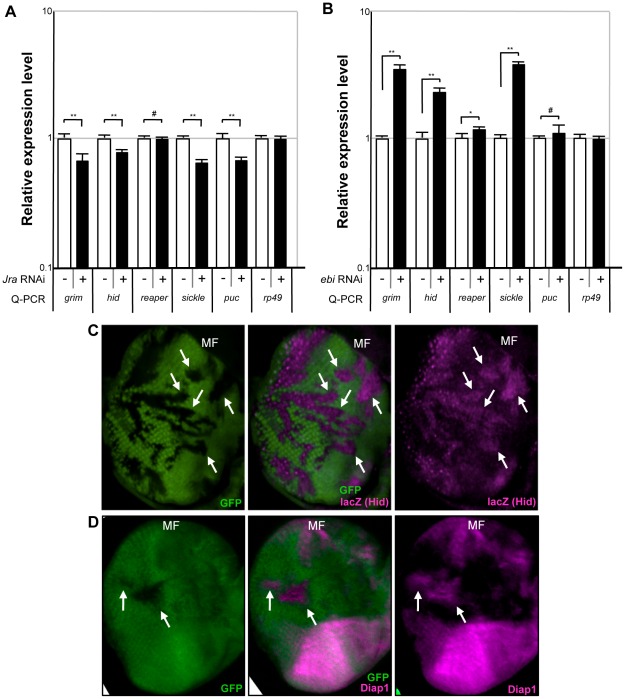

ebi antagonizes hid expression.(A, B) Quantitative real-time PCR (qRT-PCR) analysis were performed using specific primers. Each mRNA from S2 cells treated with dsRNA against Jra (A) or ebi (B) was used for the analysis. Data are shown as the mean ± SEM. * = p<0.05; ** = p<0.01; # = p>0.05. (C) Mosaic clones of ebiP. Eye discs from ey-FLP; ebiP, FRT40A/ubi-GFP, FRT40A; hid05014/+ were stained with anti-lacZ and visualized for GFP expression. ebi mutant clones showed slightly increased hid expression. MF: morphogenetic furrow. (D) Mosaic clones of ebiE4. Eye discs from heat-induced hs-FLP; ebiE4, FRT40A/ubi-GFP, FRT40A were stained with anti-Diap1 and visualized for GFP expression. Diap1 was increased in ebi mutant clones.